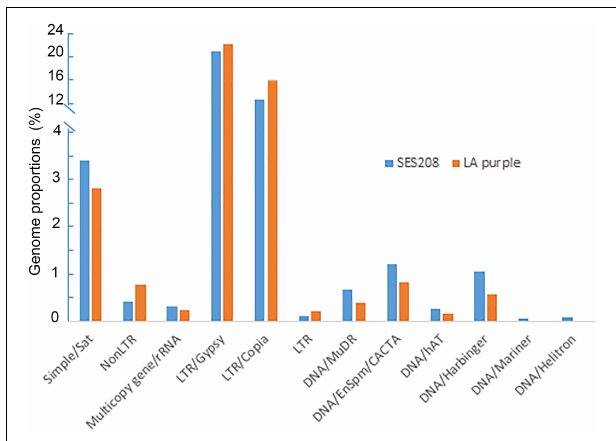
FIGURE 1 | The composition and annotation of repetitive DNA in S. officinarum LA Purple and S . spontaneum clone SES208. Annotation and genome proportions of the 338 and 305 repeat clusters in S. officinarum LA Purple and S . spontaneum clone SES208,